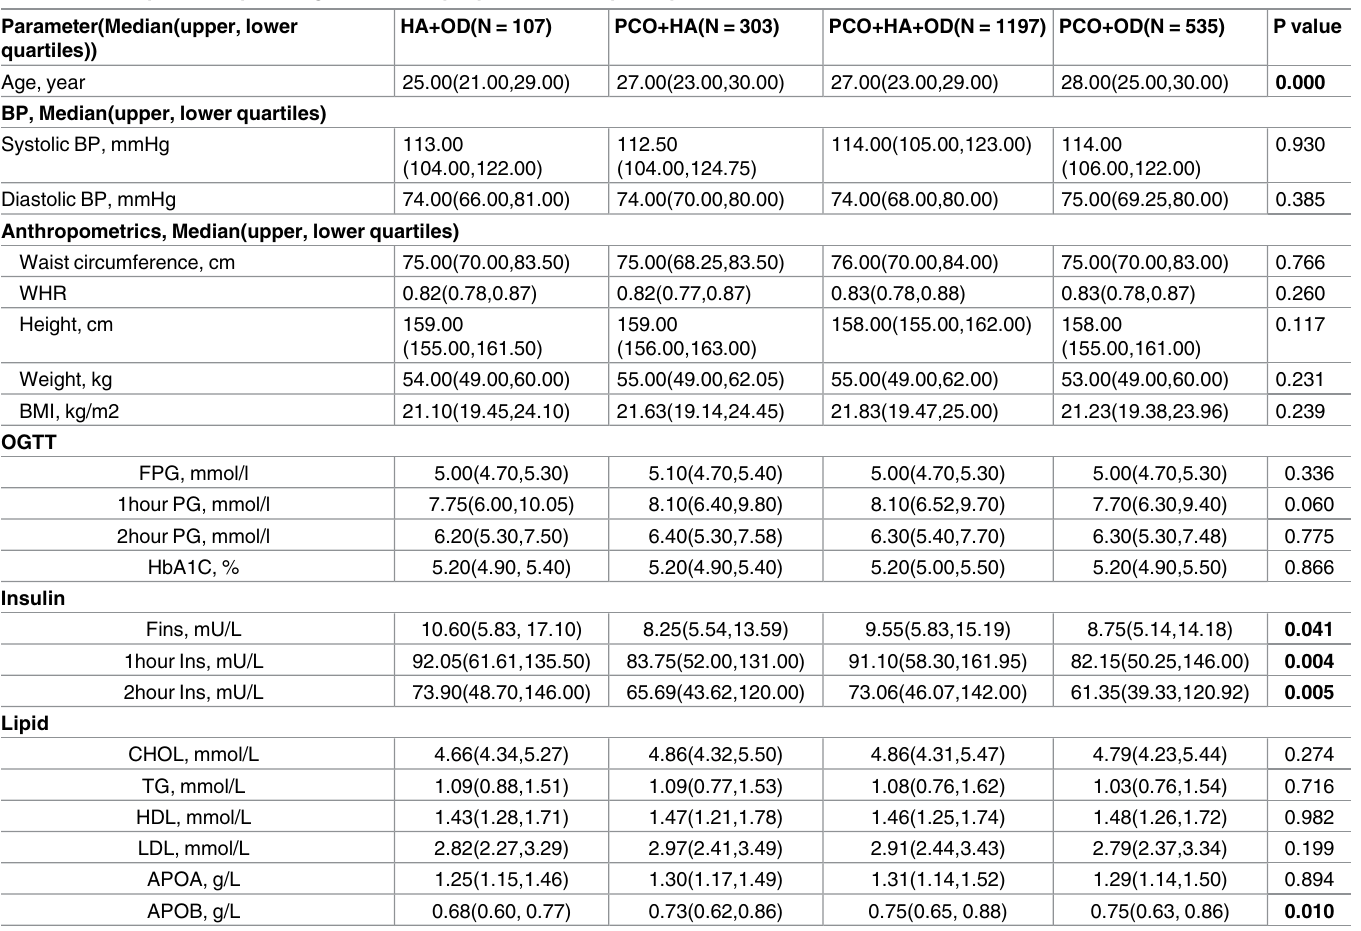
Table 1. Anthropometric, plasma glucose and lipid parameters of participants. Parameter(Median(upper, lower